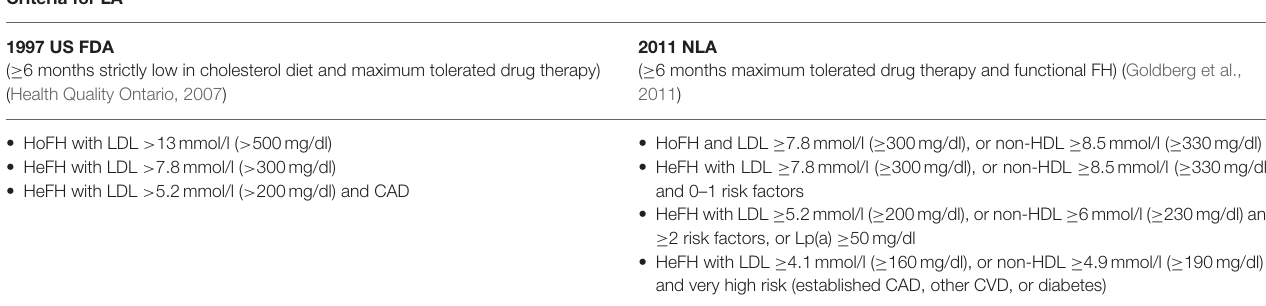
TABLE 9 | Criteria for lipoprotein apheresis. Criteria for